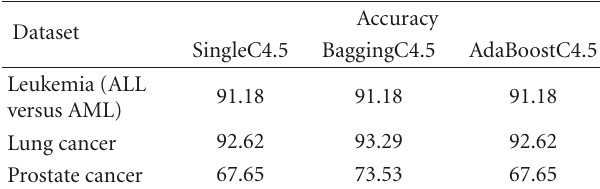
Table 2: Predictive accuracy of the classifiers